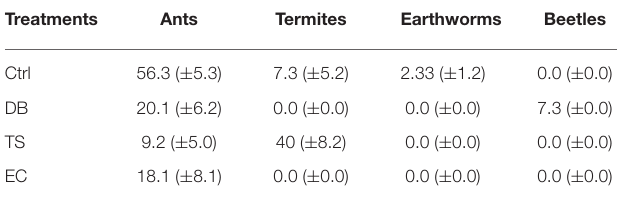
TABLE 1 | Abundance of soil macrofauna (ind m − 2 ) ( n = 3) collected below termite sheetings (TS), dung beetles (DB), and earthworm casts (EC) and in control (Ctrl) treatments.